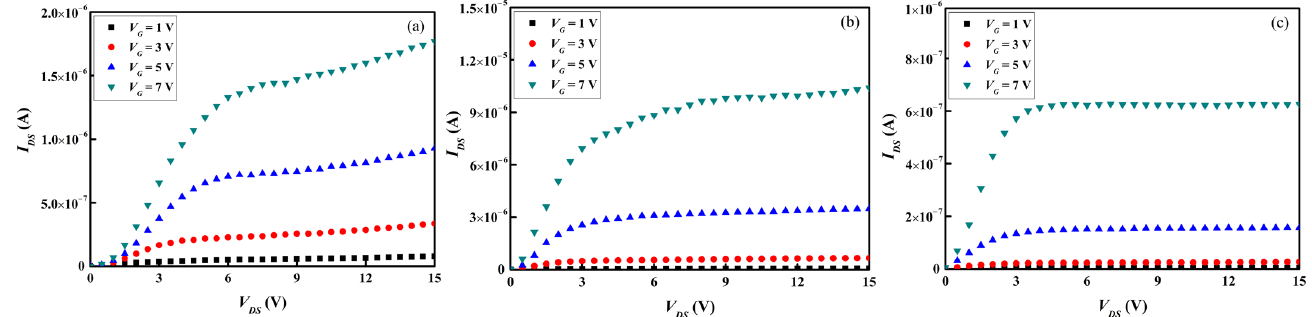
Figure 9. Transfer characteristics of TFT samples containing as-deposited ( a ) a -InGaZn 2 O 5 , ( b ) a - InGaZnO 4 , and ( c ) a -InGa 2 ZnO 5.5 active channel layers.